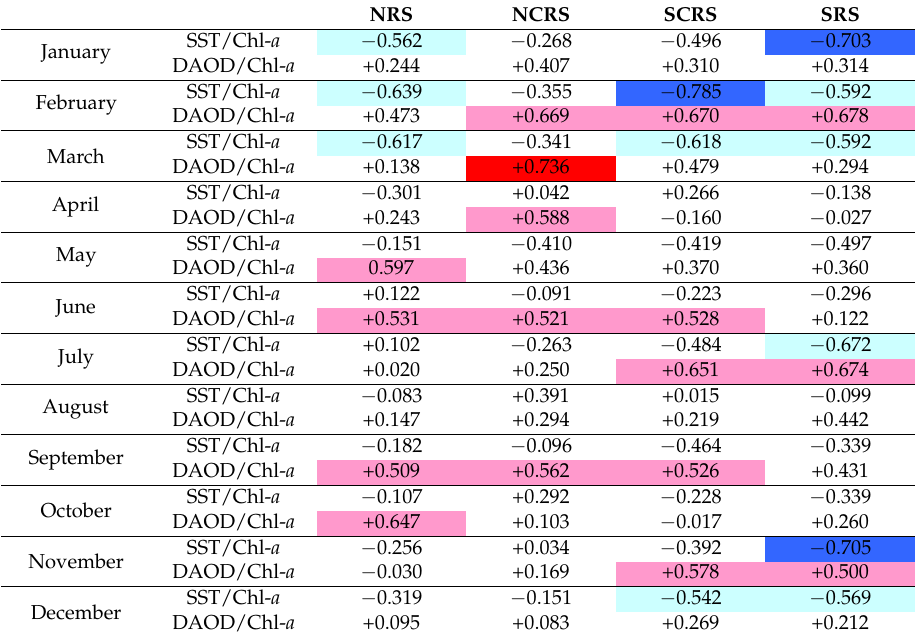
Table 2. SST/Chl- a and DAOD/Chl- a monthly anomaly correlation coefficients for the four Regions of Red Sea. Light blue indicates negative correlation between − 0.5 and − 0.7, dark blue indicates negative correlation < − 0.7. Light red indicates positive correlation between +0.5 and +0.7. Dark red indicates positive correlation >+0.7.